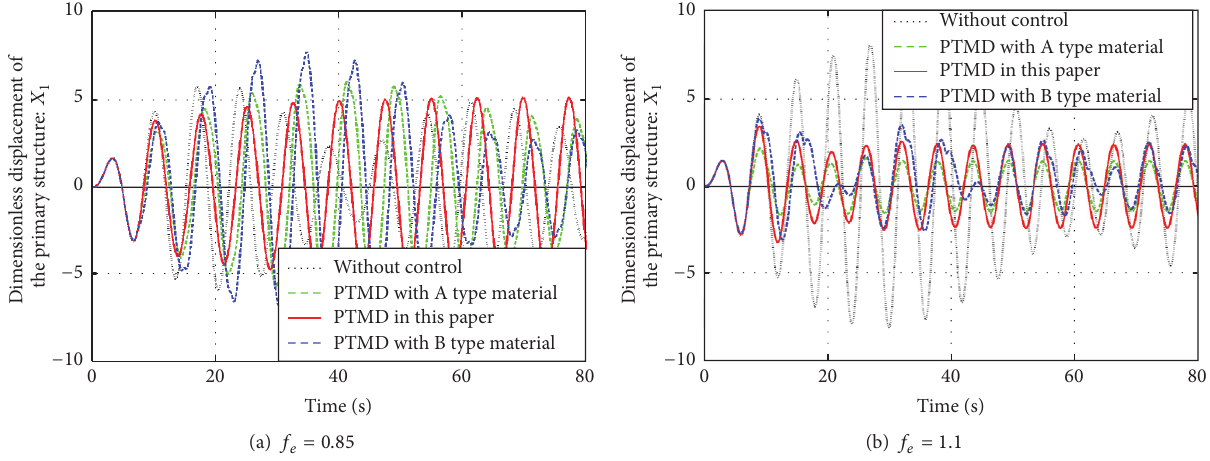
Figure 7: Control performance of PTMD with different types of materials.